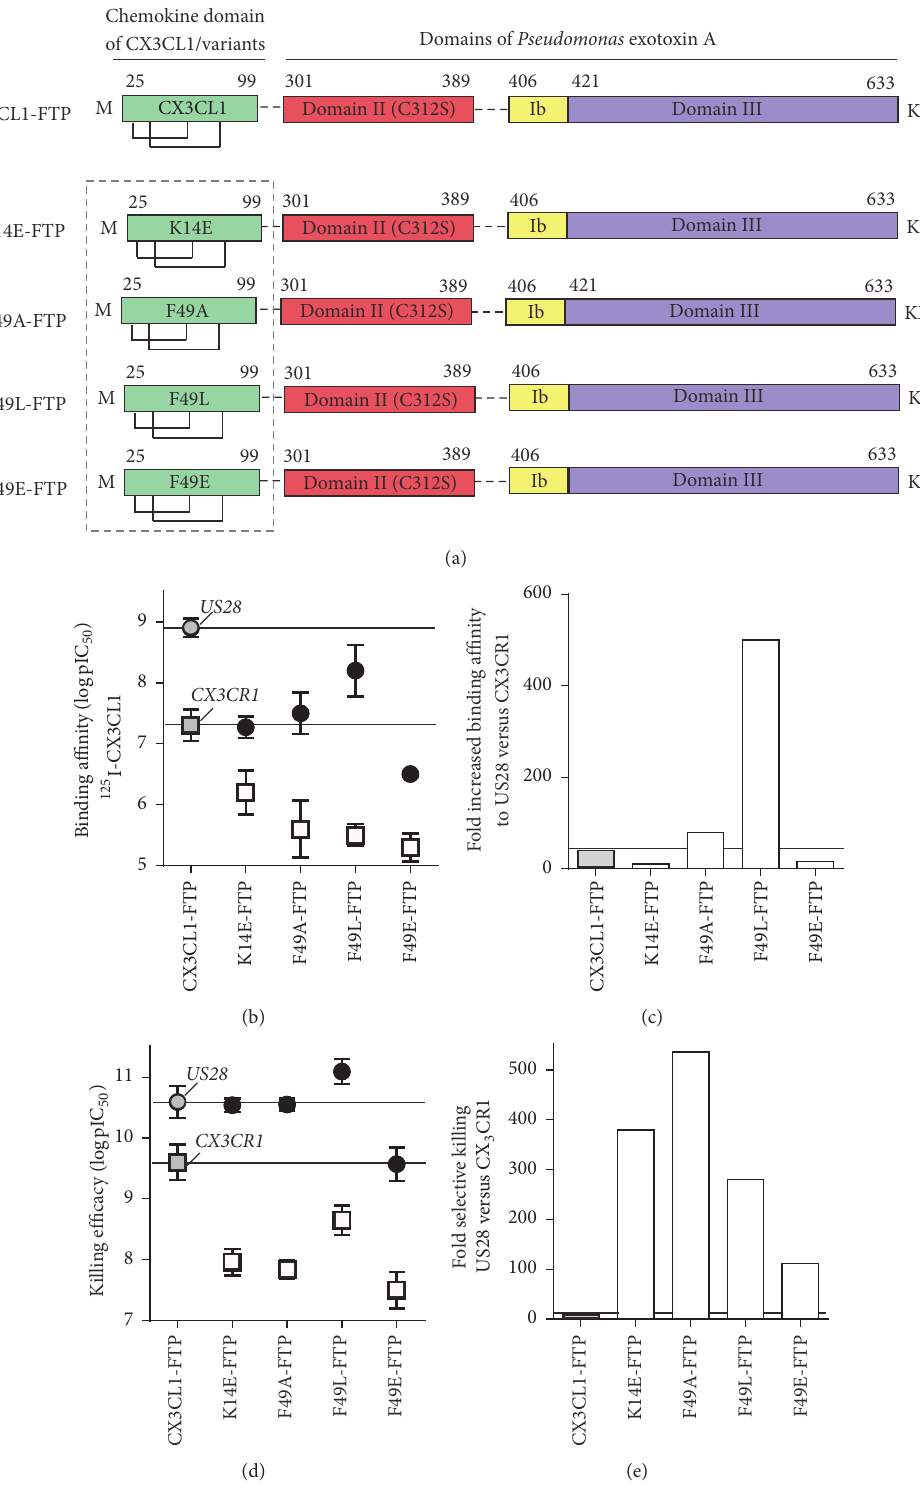
Figure 2: Design, binding, cell killing, and antiviral activity of FTPs with a modified CX 3 CL1 domain. (a) Schematic representation of CX 3 CL1-based FPTs created by fusion of CX 3 CL1 variants to domains of PE. (b) Binding of the prototype CX 3 CL1-FTP (grey symbols) and CX 3 CL1-based FTPs on HEK-293 cells induced to express US28 (black circles) and CX 3 CR1 (white squares). (c) Binding selectivity of CX 3 CL1-FTP and CX 3 CL1-based FTPs determined as fold improved affinity for US28 relative to CX 3 CR1. (d) Cell killing of CX 3 CL1-FTP (grey symbols) and CX 3 CL1-based FTPs on tetracycline induced HEK-293 cells expressing US28 (black circles) and CX 3 CR1 (white squares). (e) Selectivity of CX 3 CL1-FTP and CX 3 CL1-based FTPs determined as fold improved potency in killing US28- relative to CX 3 CR1-expressing cells. Values present IC 50 values from 3–5 independent biological replicates (b) and